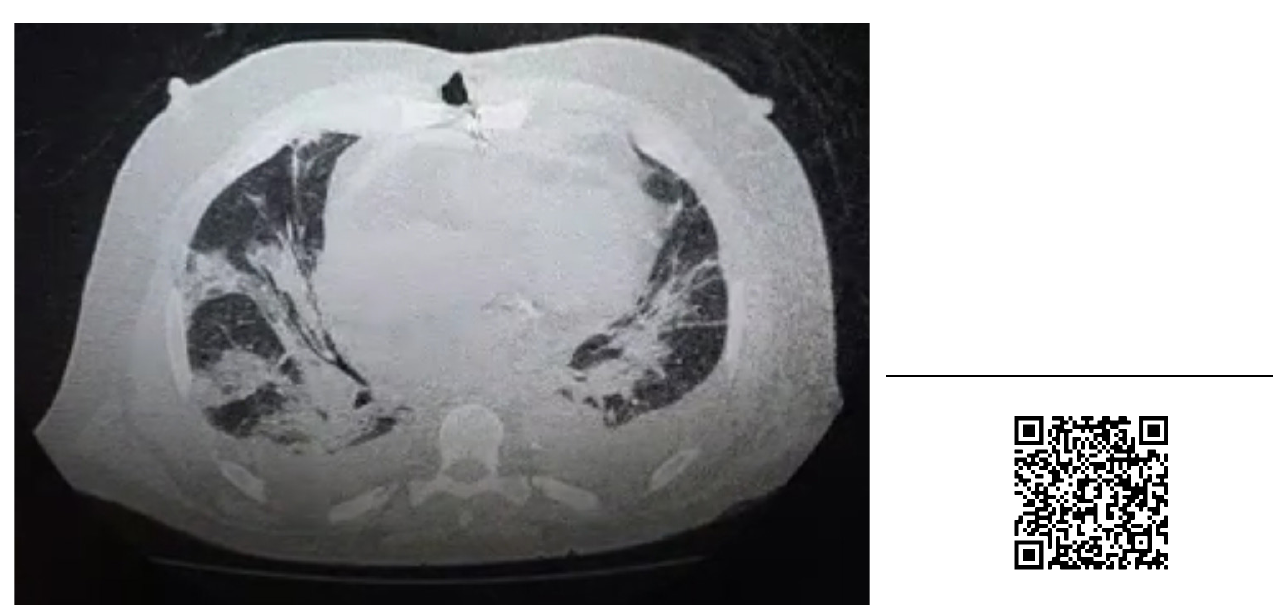
Fig. 2 - Chest CT revealing multiple peripheral ground-glass